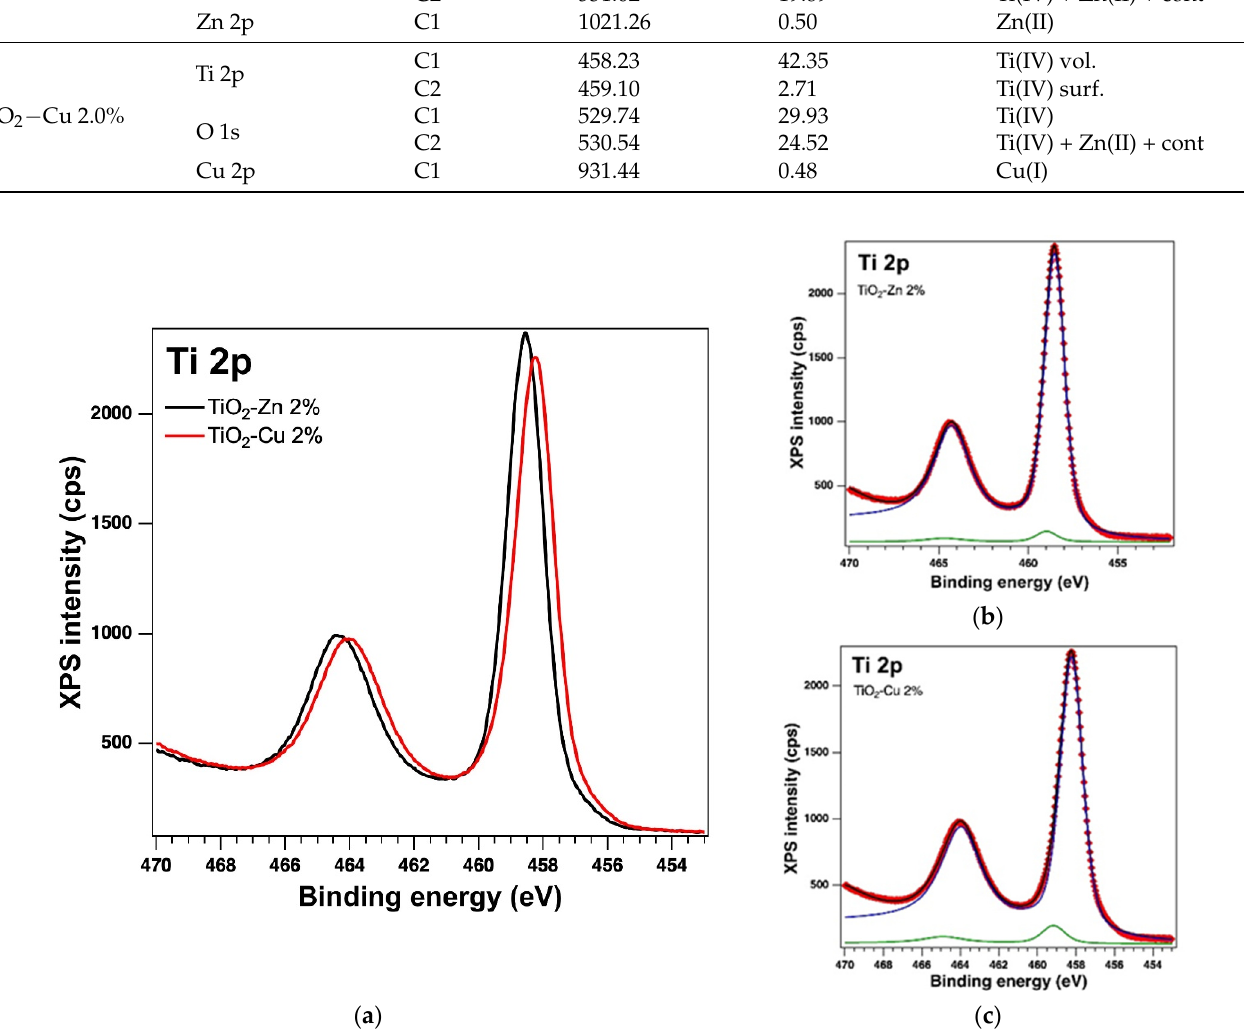
Figure 5. XPS spectra of the core level Ti 2p ( a ) overlayed XPS spectra of the samples prepared by the sol − gel method and the experimental data (red symbols) with the fit and deconvolutions given separately for ( b ) the sample with Zn and ( c ) the sample with Cu; deconvolutions: components C1–blue line and C2–green line.